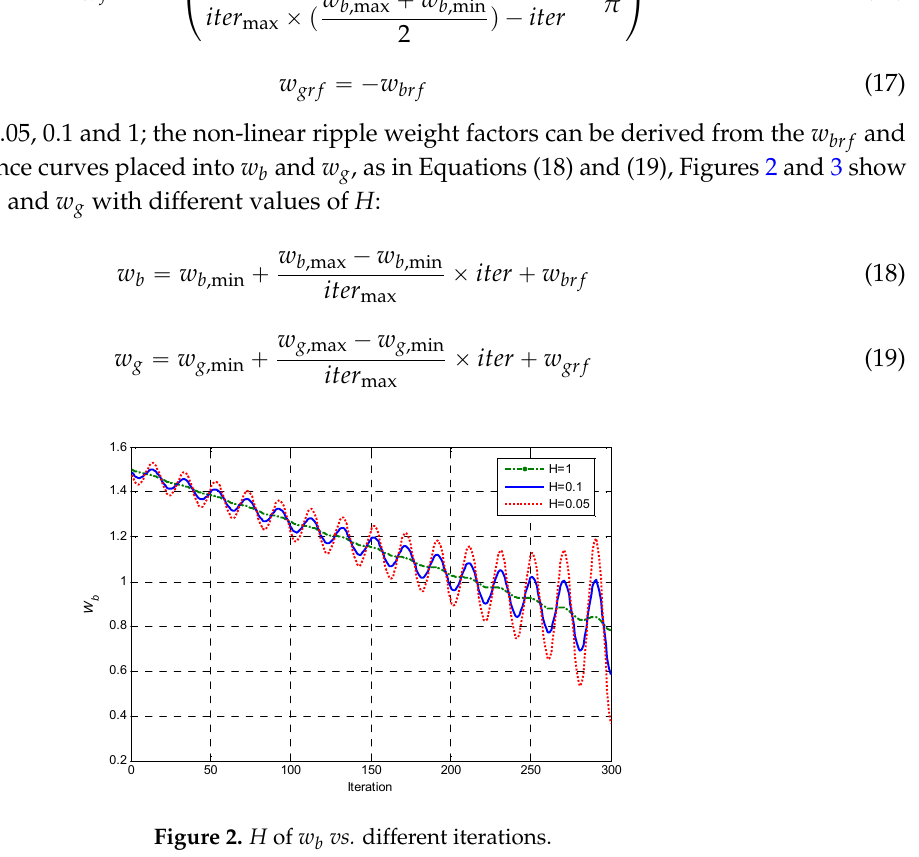
Figure 2. H of w b vs. different iterations.